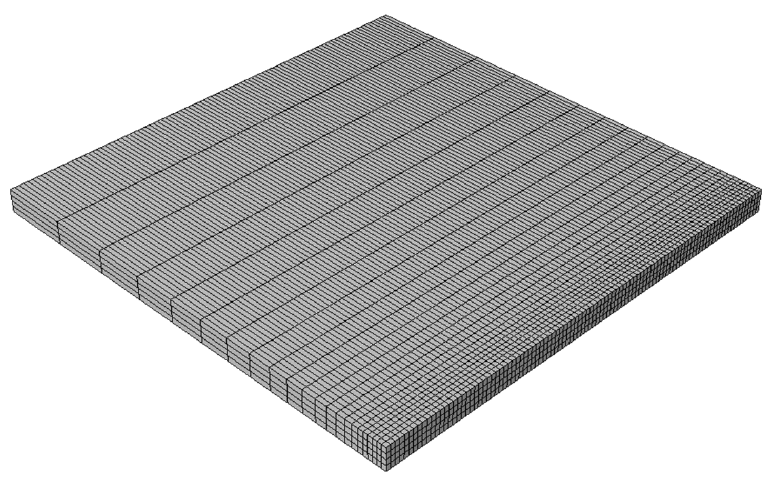
Figure 10. Mesh model of the plate.